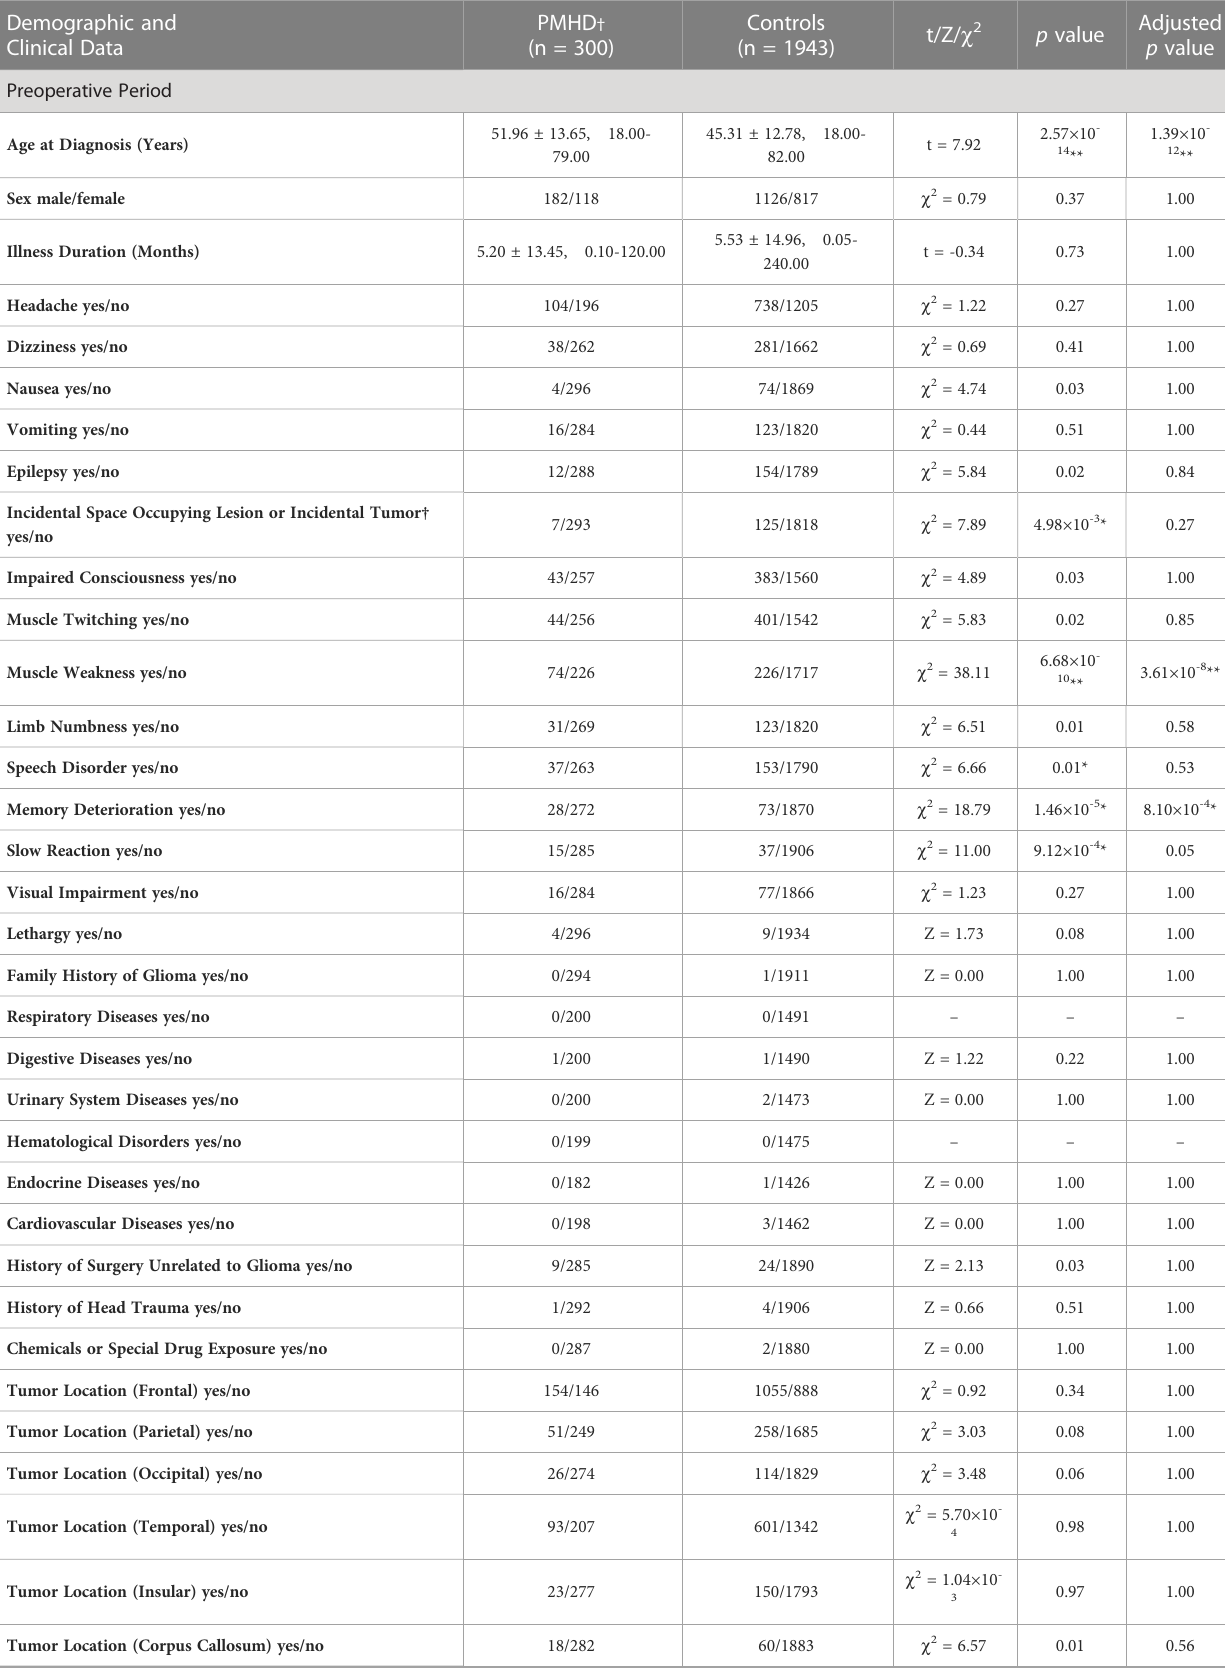
TABLE 1 Demographic and clinical data of patients with postoperative mental health disturbances and controls. Demographic and Clinical